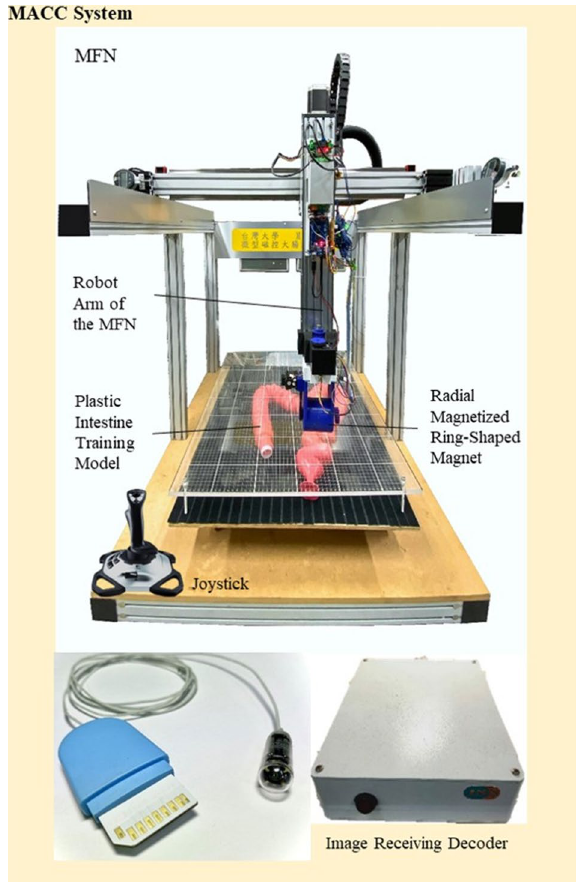
Figure 4. Apparatus of the MACC system, consisting of the MFN, MCC, image receiving decoder, and